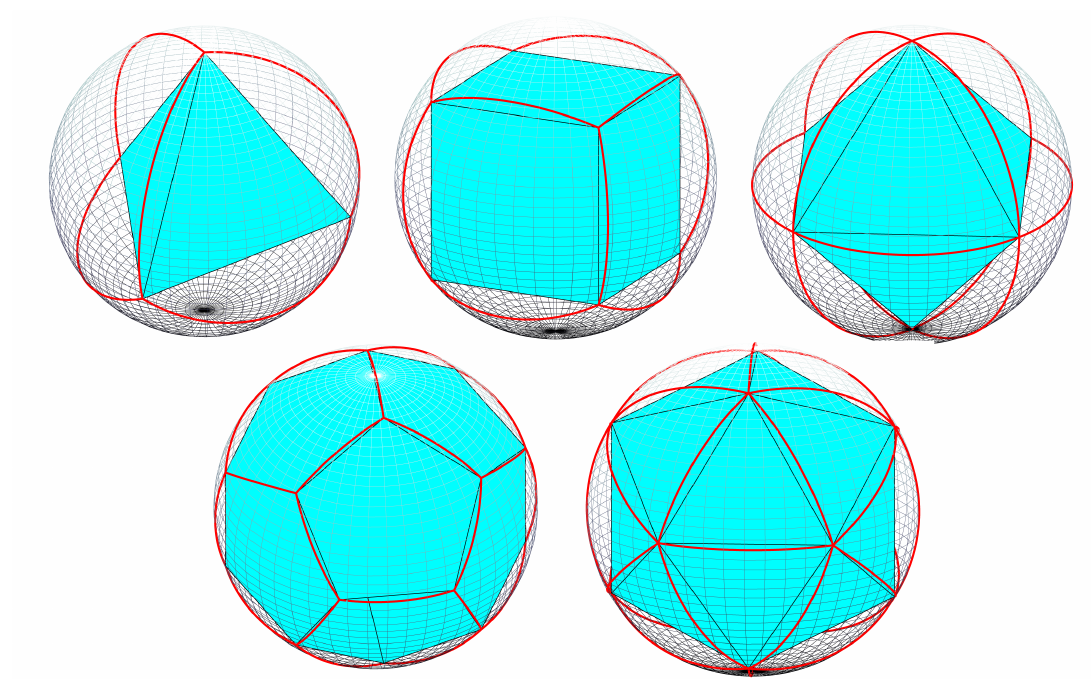
Figure 3. Spherical tessellations of the five regular